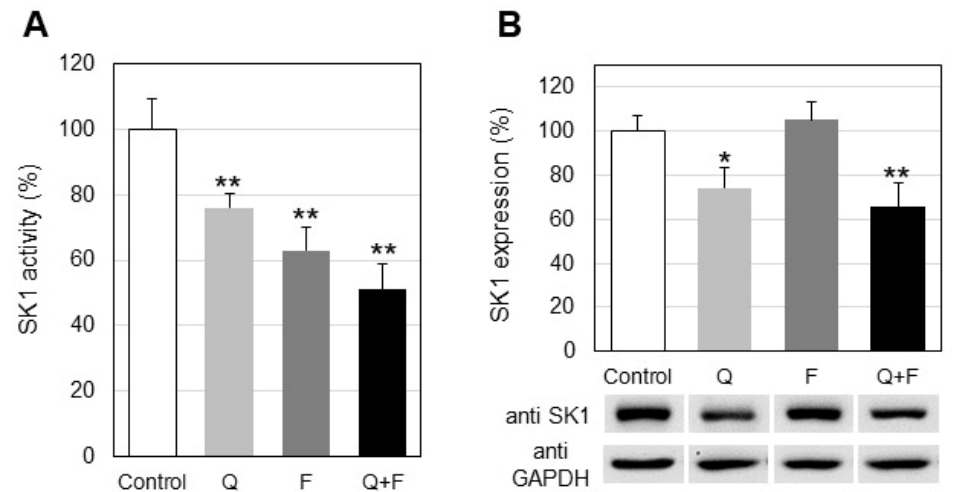
Figure 6. Changes in the activity ( A ) and protein expression ( B ) of sphingosine kinase 1 (SK1) in control and treated with quercetin (Q) and fingolimod (F) HepG2 cells. Values are expressed as % of controls (100%). Representative images from Western blot analysis with specific antibodies to sphingosine kinase 1 (anti-SK1) are shown at the lowermost of panel B. Reaction with anti-glyceraldehyde-3-phosphate dehydrogenase antibodies (anti-GAPDH) was used as an internal control for loading. Values are means ± SD. Statistical significance is presented as comparison of treated cells with controls. * p < 0.05; ** p < 0.01.